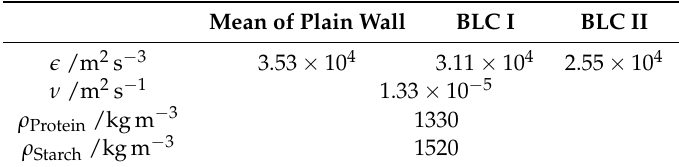
Table 1. Parameters used to calculate contact numbers of